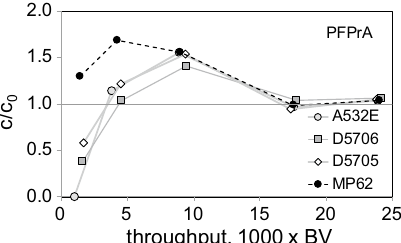
Fig. 8 Normalised breakthrough curves of PFPrA for different